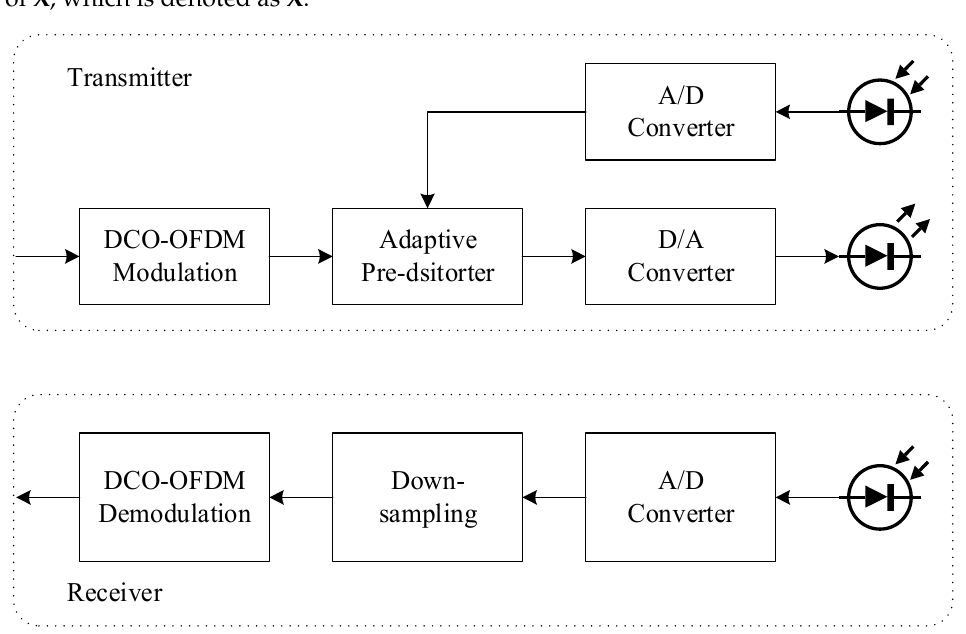
Figure 2. Illustration of DCO-OFDM VLC system with adaptive